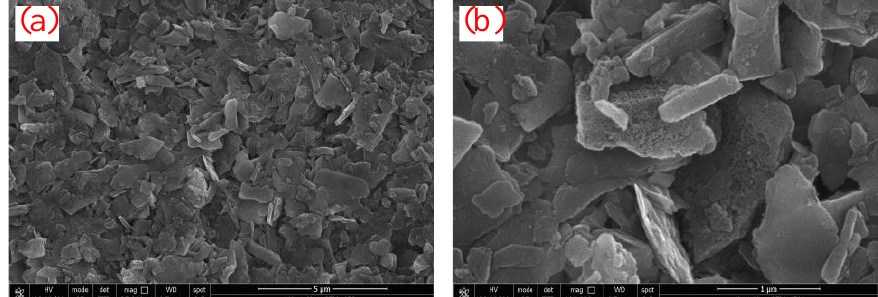
Figure 1. Microscopic morphology of sediments: ( a ) 5 μm; ( b ) 1 μm.